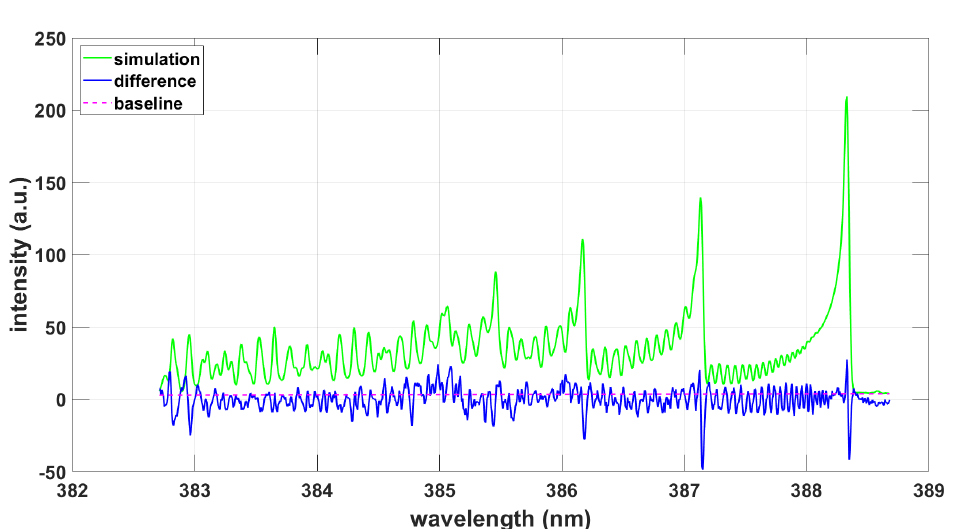
Figure 4. Simulation using CNv-lsf data and the NMT program, T = 8140 K, ∆ λ = 0.036